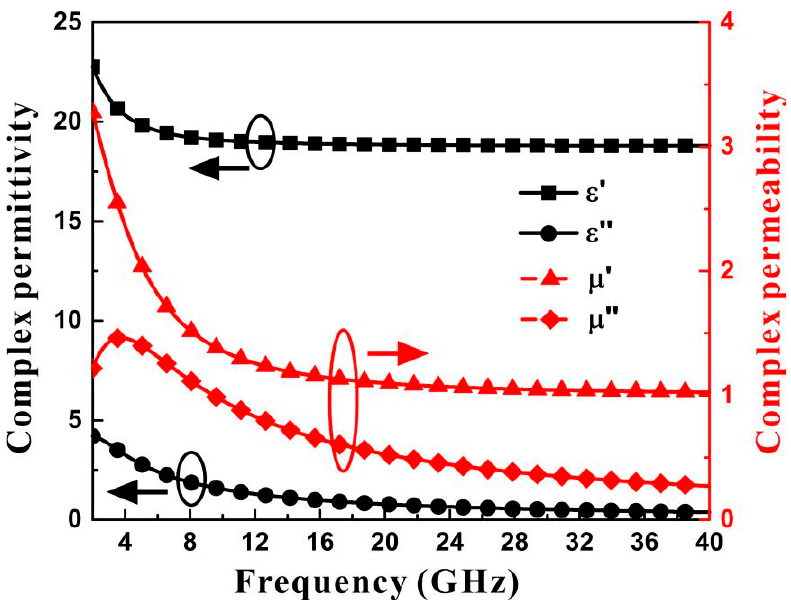
Figure 1. Experimental complex permittivity and complex permeability of CI/MWCNT/PLA hybrid material at 2–40 GHz.